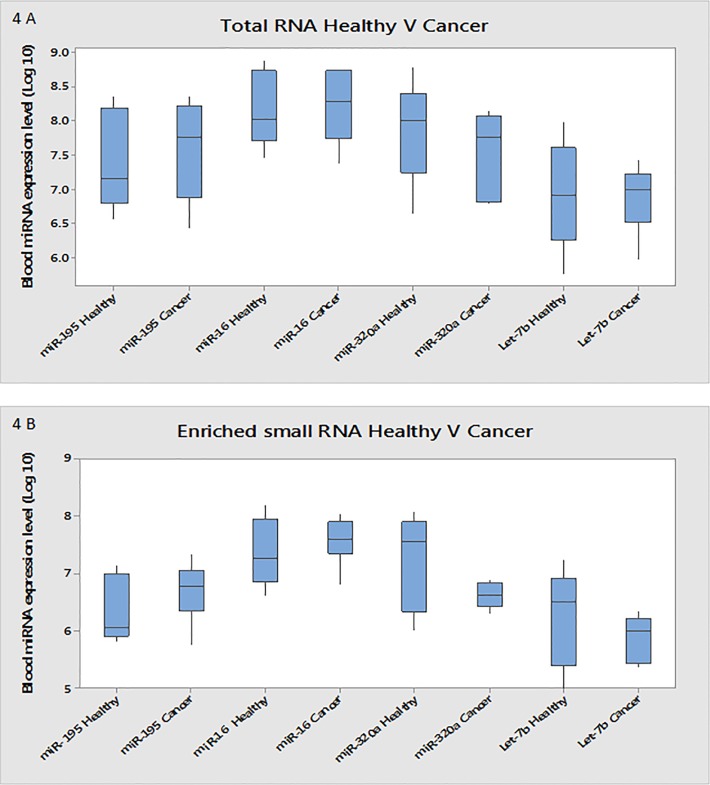
Differential analysis of miRNA isolated from total and enriched RNA from complete sample set.(A) Differential expression of miRNAs between healthy and cancer samples measured in total RNA from the complete sample set measured using RT-qPCR A 2.38 fold decrease is observed (with a P value of 0.111), in miR-320a from Healthy (1.58E +08) to Cancer (6.63E +07) state. Log 10 box-plots indicating changes in expression of miR-195, miR-16 and Let-7b from healthy to cancer state measured in total RNA using RT-qPCR. (B) Differential expression of selected miRNAs between healthy and cancer samples measured in enriched small RNA from the complete sample set measured using RT-qPCR An 8.89 fold decrease is observed (with a P value of 0.006), in miR-320a from Healthy (4.20E +07) to Cancer (4.72E +06) state. Log 10 box-plots indicating changes in expression of miR-195, miR-16 and Let-7b from healthy to cancer state measured in enriched small RNA using RT-qPCR.